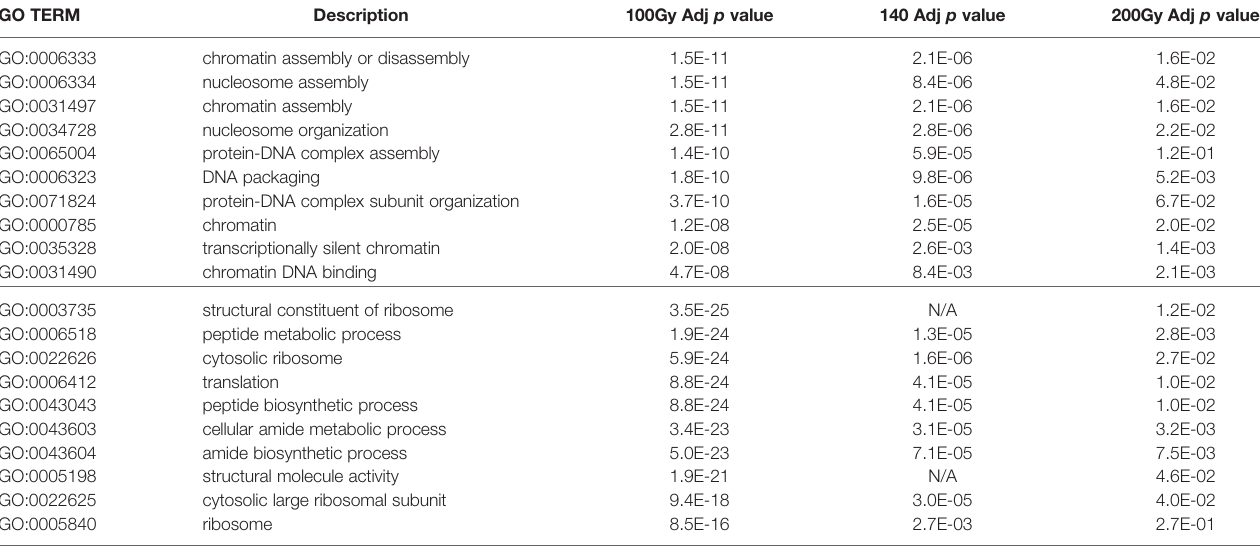
TABLE 2 | Comparison of Go Term FDR p values across doses at 6h (top half) and 20h (bottom half) post-irradiation. GO TERM